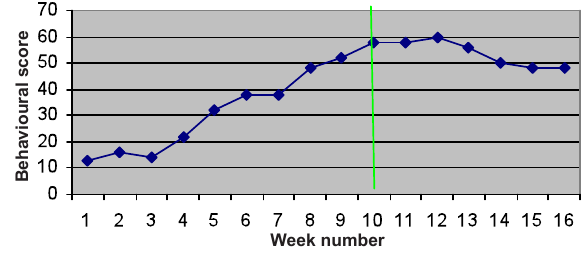
The three weeks which 3. are the 10 th , 11 th and 12 th 3 was 3